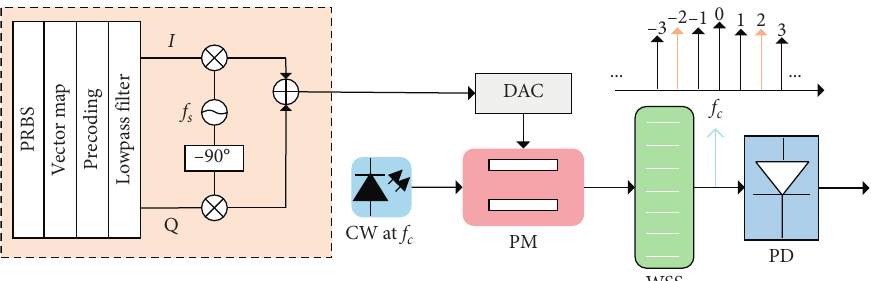
Figure 10: The principle diagram of multifrequency vector signal